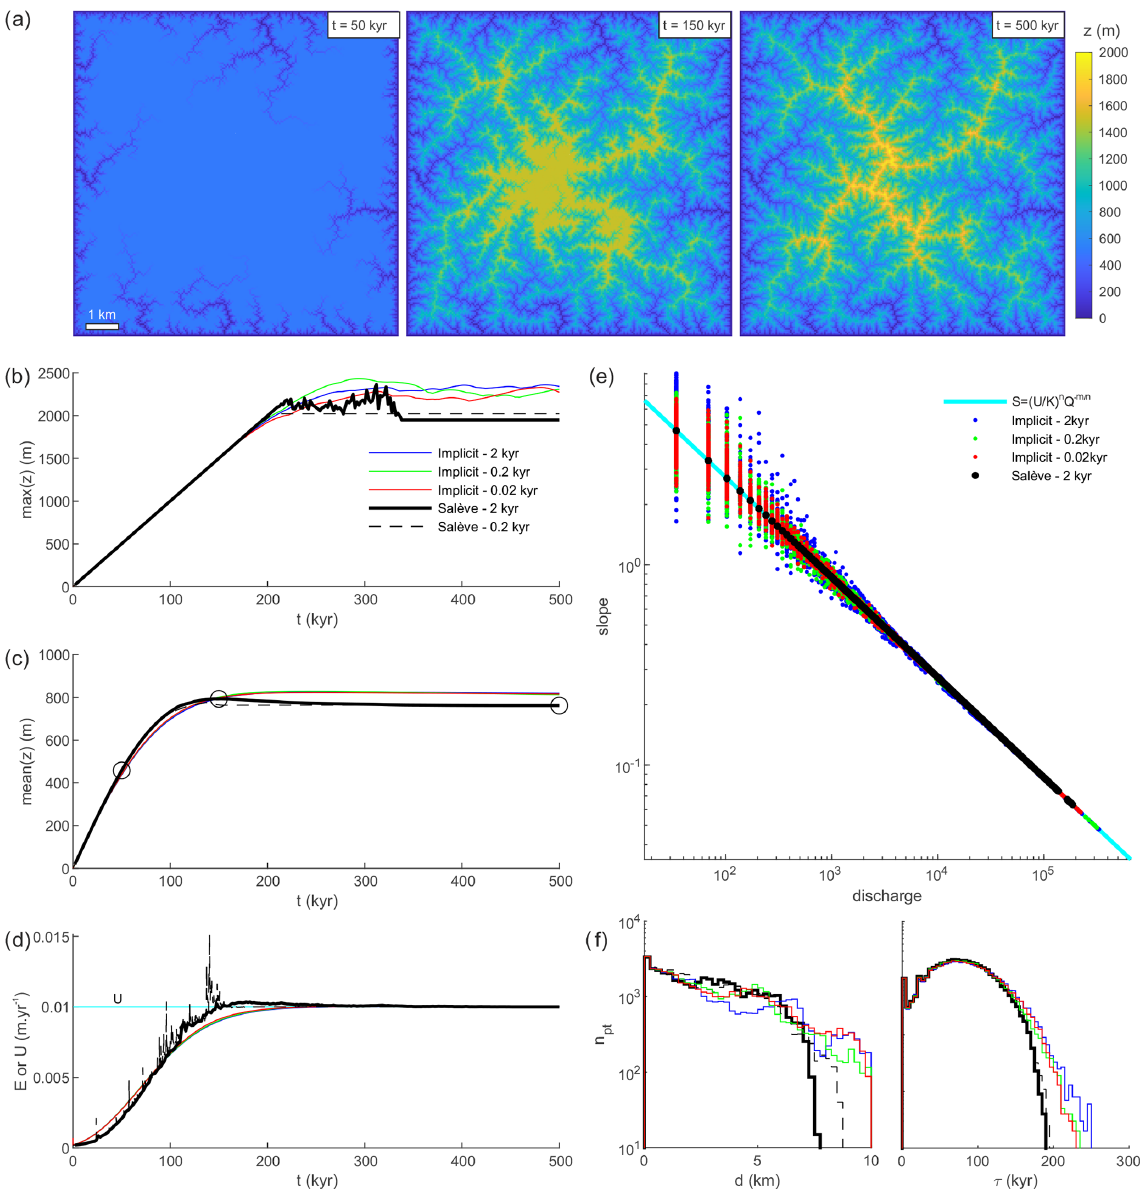
Figure 4. Dynamic behaviour of the Salève model. (a) Time evolution of the modelled topography after 50 (left panel), 150 (middle panel) and 500kyr (right panel). Time evolution of the (b) max elevation, (c) mean elevation and (d) mean erosion rate for Salève, using a time step of (cid:49)t = 2kyr (black line) and 0.2kyr (dashed black line) and for the implicit solution with (cid:49)t = 2kyr (blue line), 0.2kyr (green line) and 0.02kyr (red line). The uplift rate U is shown in panel (d) with a cyan line. (e) Slope–discharge distributions at steady state (at 500kyr) for the three models compared to the predicted relationship (cyan line). No binning is done, and all the model nodes are represented in panel (d) . (f) Histograms of upstream distances d (left panel) and response times τ (right panel) for the different models at steady